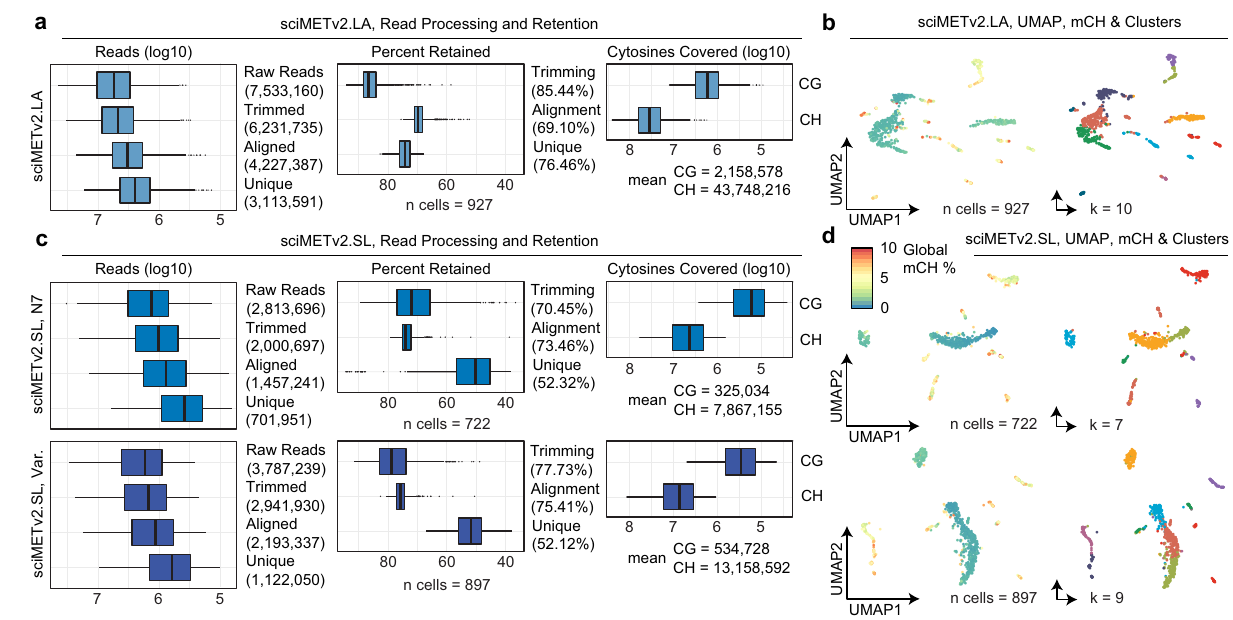
Fig. 2 | sciMETv2 technical performance. a Read processing and retention for sciMETv2.LA,meanvaluesinparentheses. b UMAPprojectioncoloredbyglobalCH methylation levels (left) or cluster (right). c Read processing and retention for